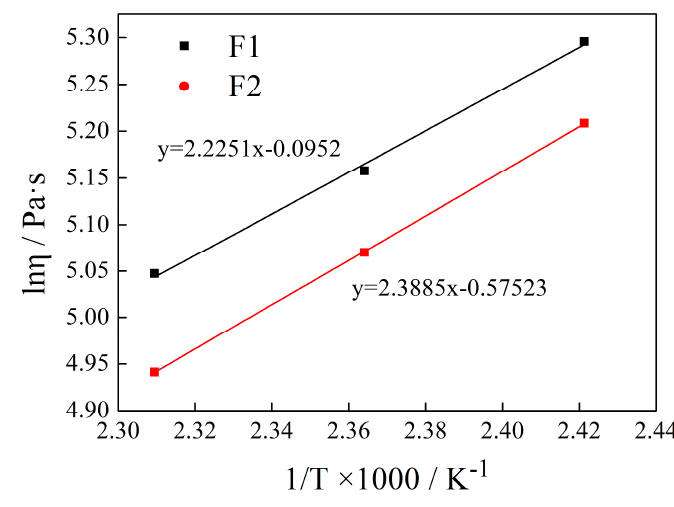
Figure 4. Temperature dependence of viscosity of the feedstocks.